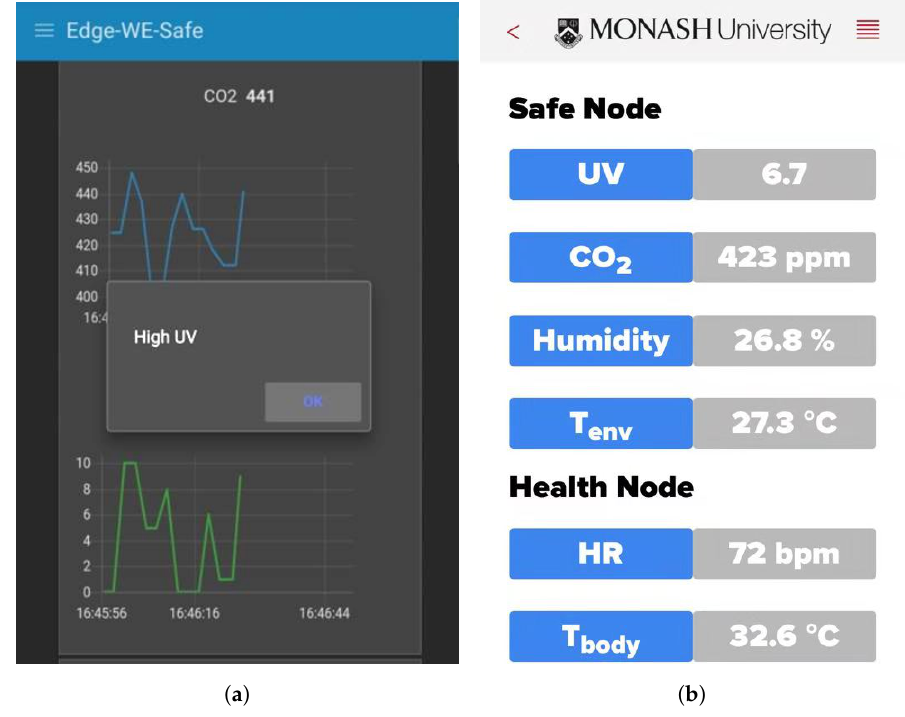
Figure 12. The mobile website hosted on the IoT gateway and the mobile application. ( a ) A screen-shot of the mobile website. ( b ) A screen-shot of the mobile